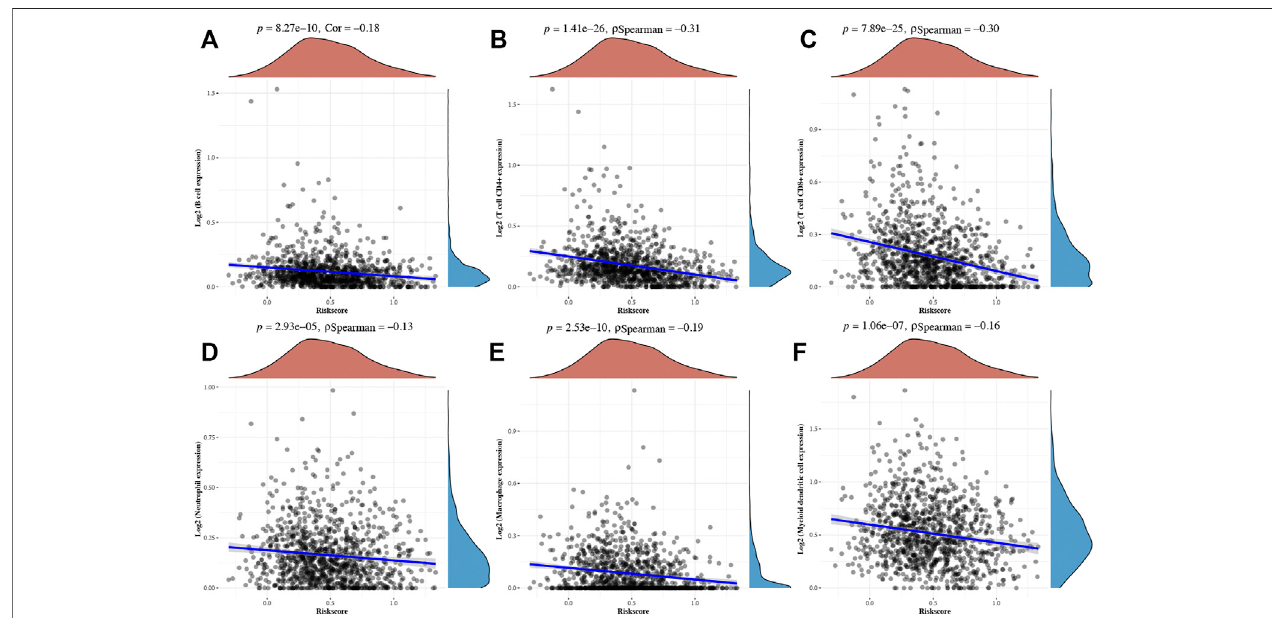
FIGURE 5 | Correlation between riskscore and immune in fi ltration in BRCA. The correlation between riskscore and the expression of B cells (A) , CD4 + T cells (B) , CD8 + T cells (C) , neutrophils (D) , macrophage (E) , and dendritic cells (F) in BRCA.